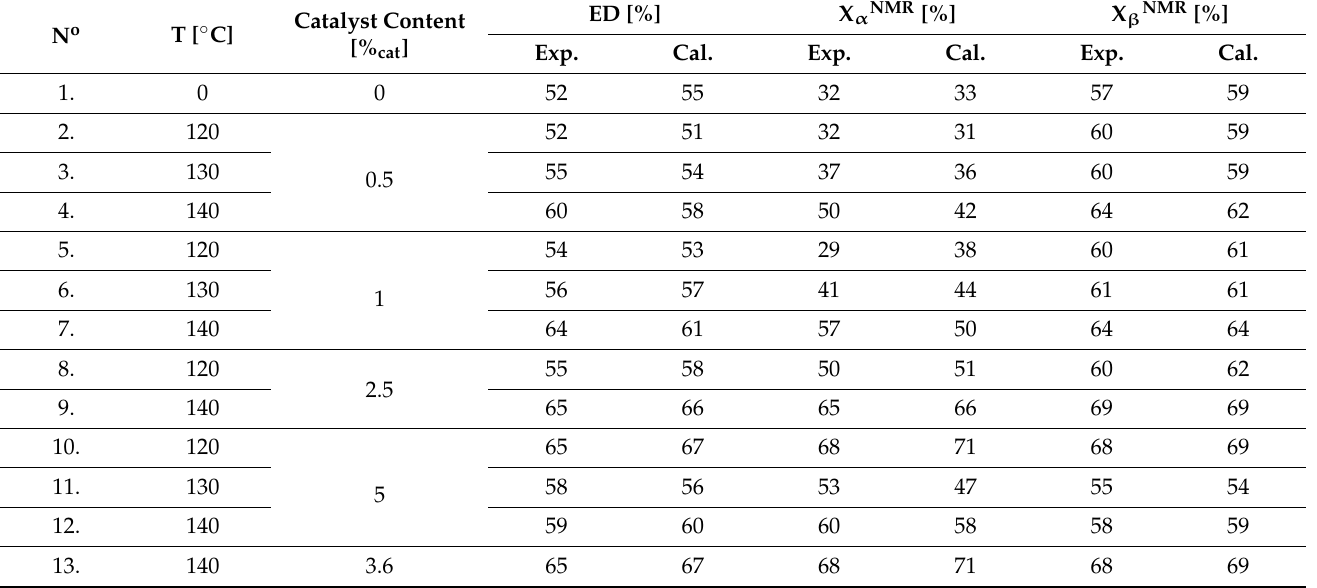
Table 3. The comparison of the optimization results (exp.) with calculated values (cal.) derived from the analysis of the synthesis products.